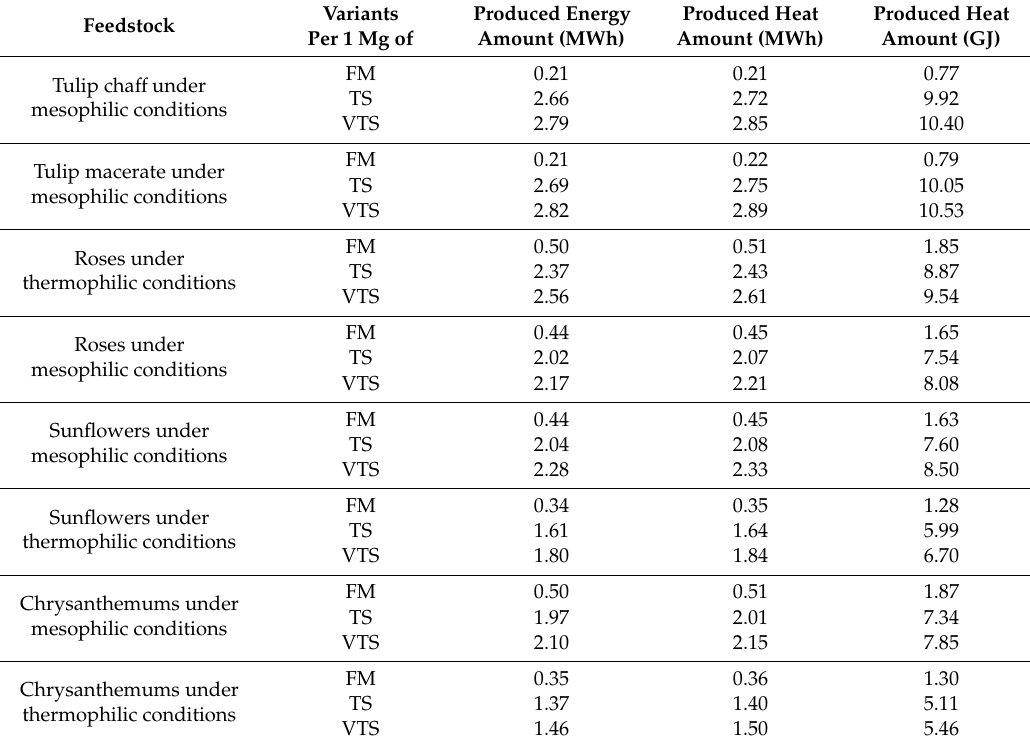
Table 4. Energy production of each analyzed